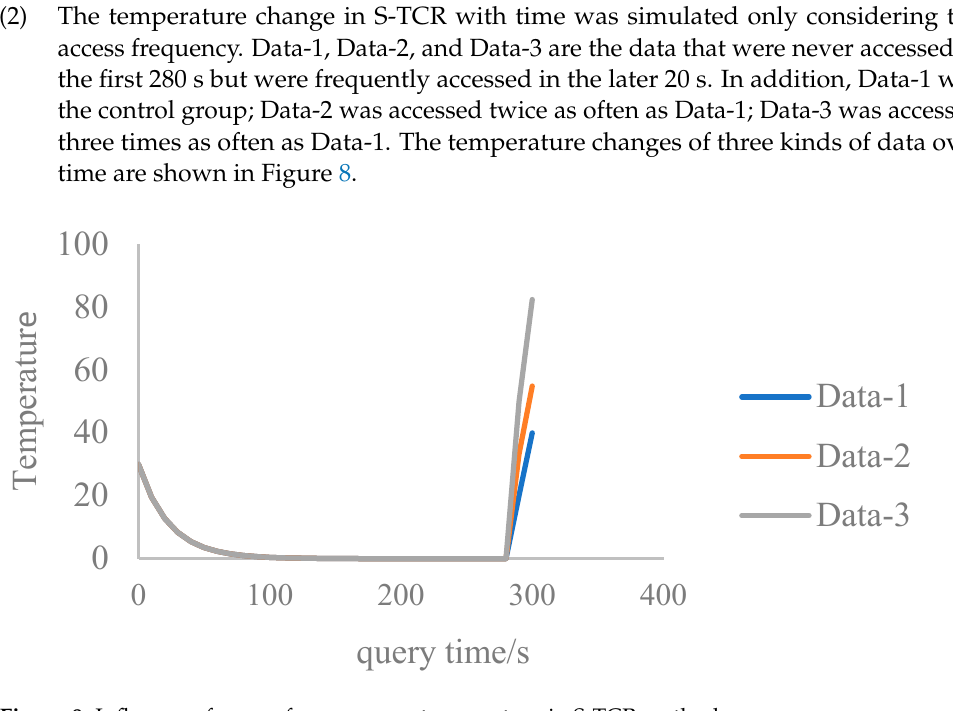
Figure 7. Influence of access time on temperature in S-TCR method.